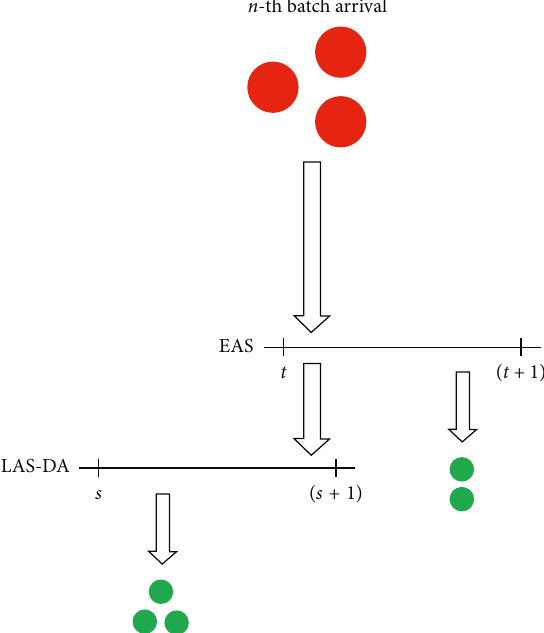
Figure 5: A comparison between EAS and LAS-DA at the n -th batch-arrival.